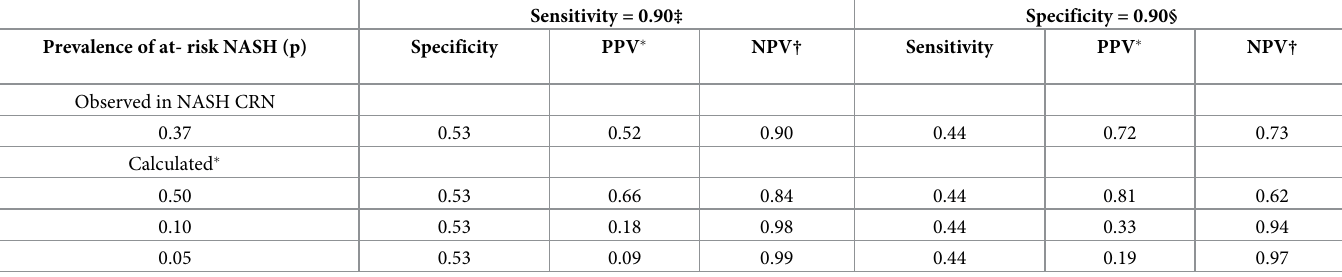
Table 3. Diagnostic accuracy of FAST ™ at varying prevalences of at-risk